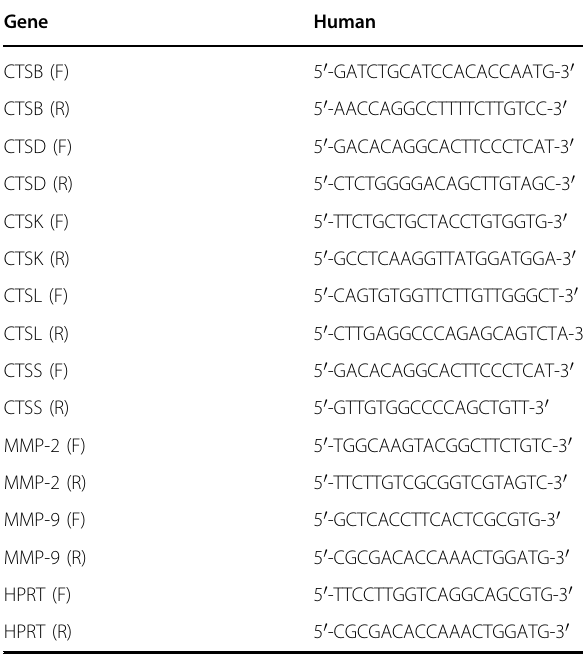
Table 1 Primer sequences used in the